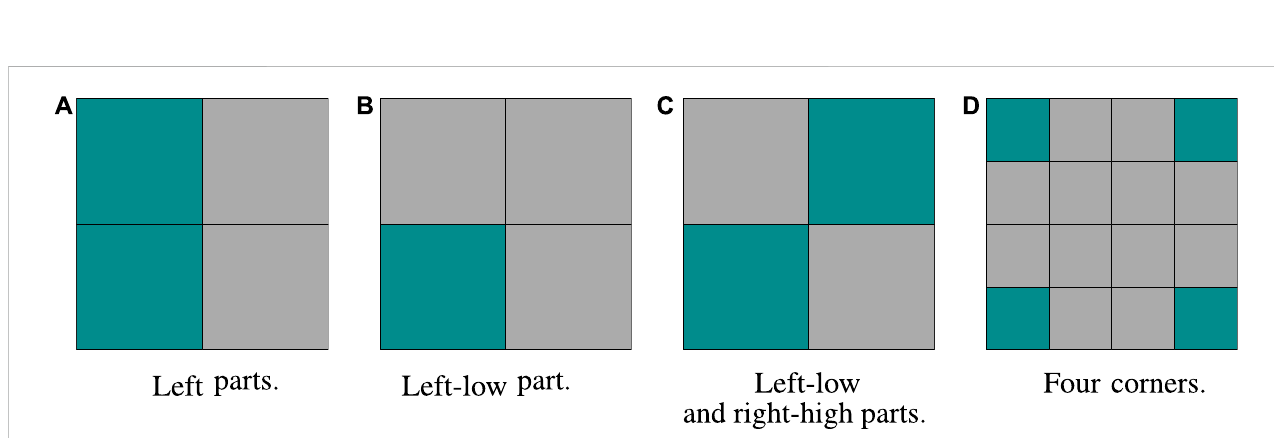
FIGURE 8 Different chosen surface Γ c , cyan color represents the chosen parts. (A) Left parts. (B) Lower left part. (C) Lower left and upper right parts. (D) Four